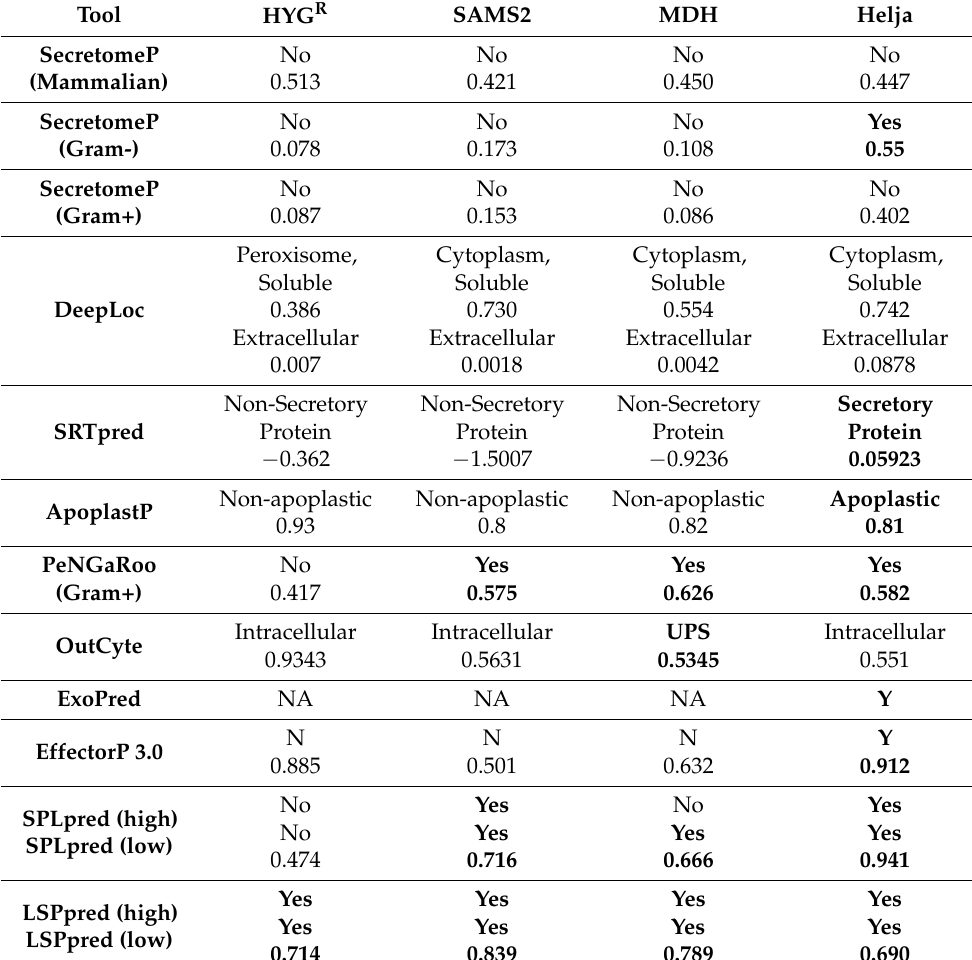
Table 3. LSPDB results. Results of prediction tools applied to the three best plant LSP candidates and bacterial HYG R , with the predicted category score shown. Correct predictions of extracellular location for the LSPs are in